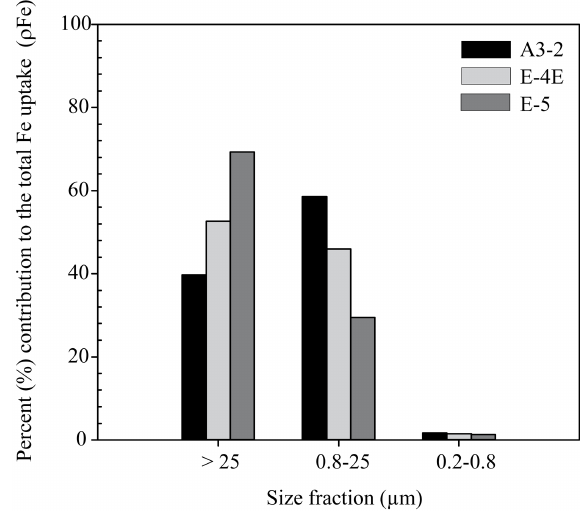
Figure 3. Relative contribution of different size fractions to total Fe uptake ( ρ Fe). The percent contribution was calculated from Fe uptake fluxes integrated over the euphotic layer at plateau (A3-2) and downstream plume (E-4E and E-5)